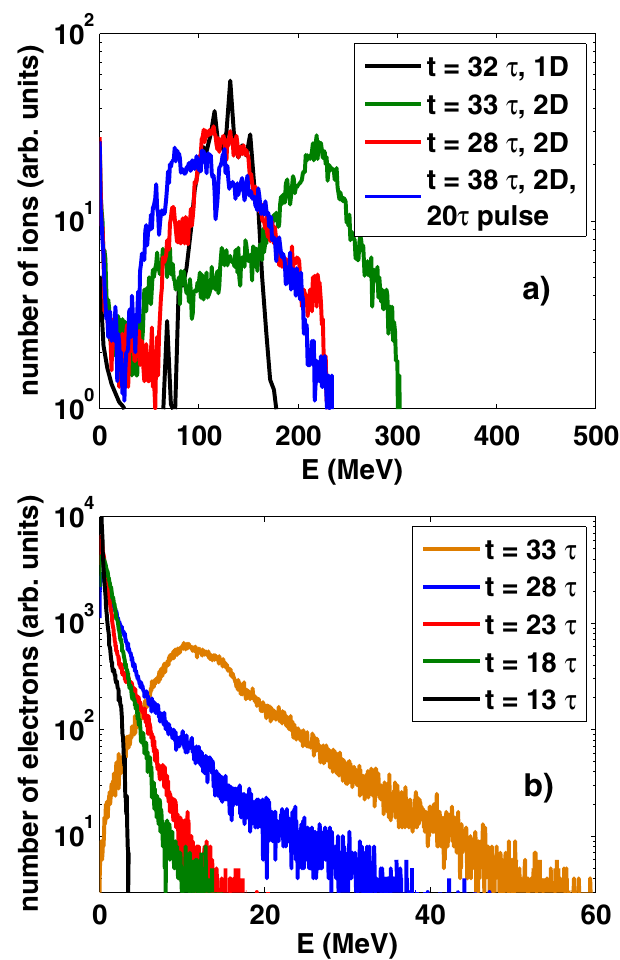
FIG. 11. (Color) The energy distributions of ions [panel (a)] and electrons [panel (b)] in the 2 (cid:1) wide central part of the simulation box in the 2D3V PIC simulation with the parameters of Fig. 8. The distribution from 1D3V PIC simulation with the same parameters is included for comparison in panel (a). The energy distribution of ions resulting from the 2D3V PIC simulation with a shorter ( 20 (cid:2) long) laser pulse is plotted in the time 18 (cid:2) after the end of the laser-target interaction to demonstrate that the quasi- monoenergetic distribution is preserved. The energy distribution of electrons in panel (b) is peaked at very high energy in the time 33 (cid:2) . This is the consequence of the explosion of the central part of the foil which became underdense to the laser pulse before this